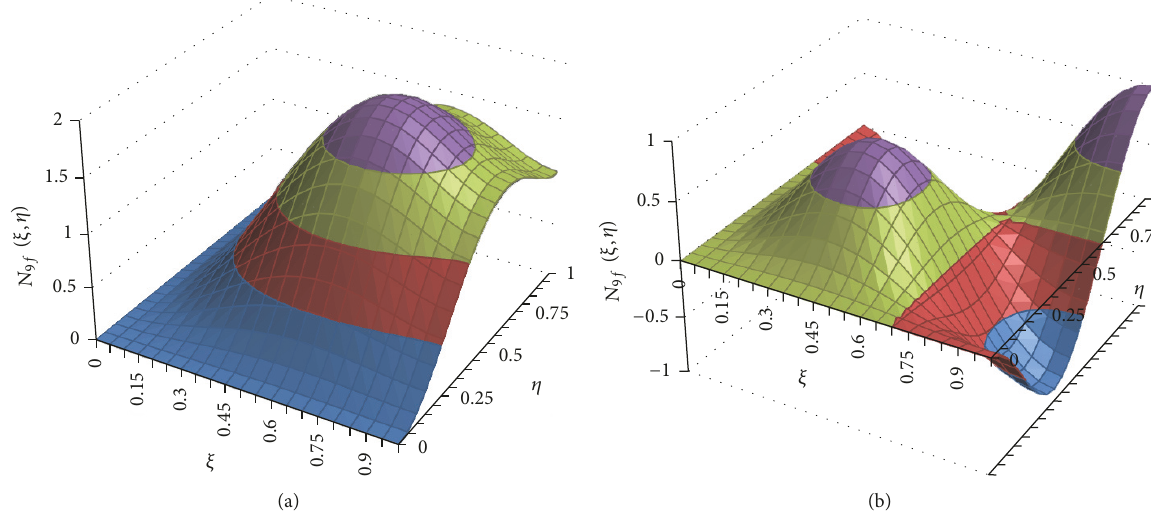
Figure 11: Shape function 𝑁 9𝑓 at 𝜔 1 (a) and 𝜔 2